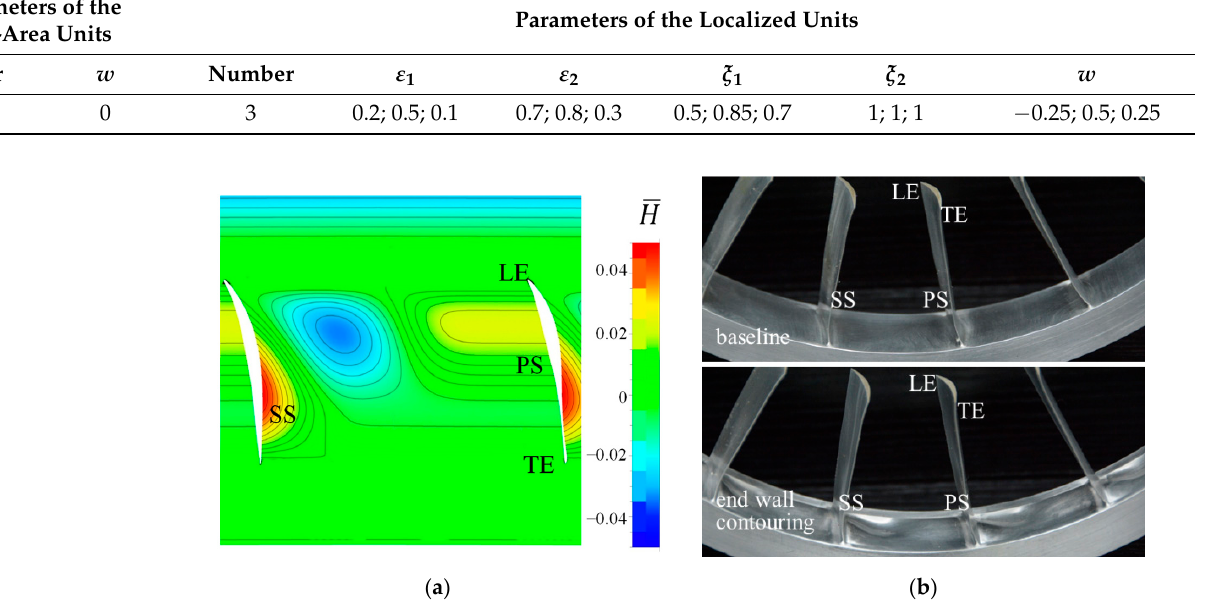
Figure 13. The end wall contouring in the compressor stage ( a ) Normalized end wall contouring height; ( b ) Stator component of baseline and end wall contouring for the experiment.